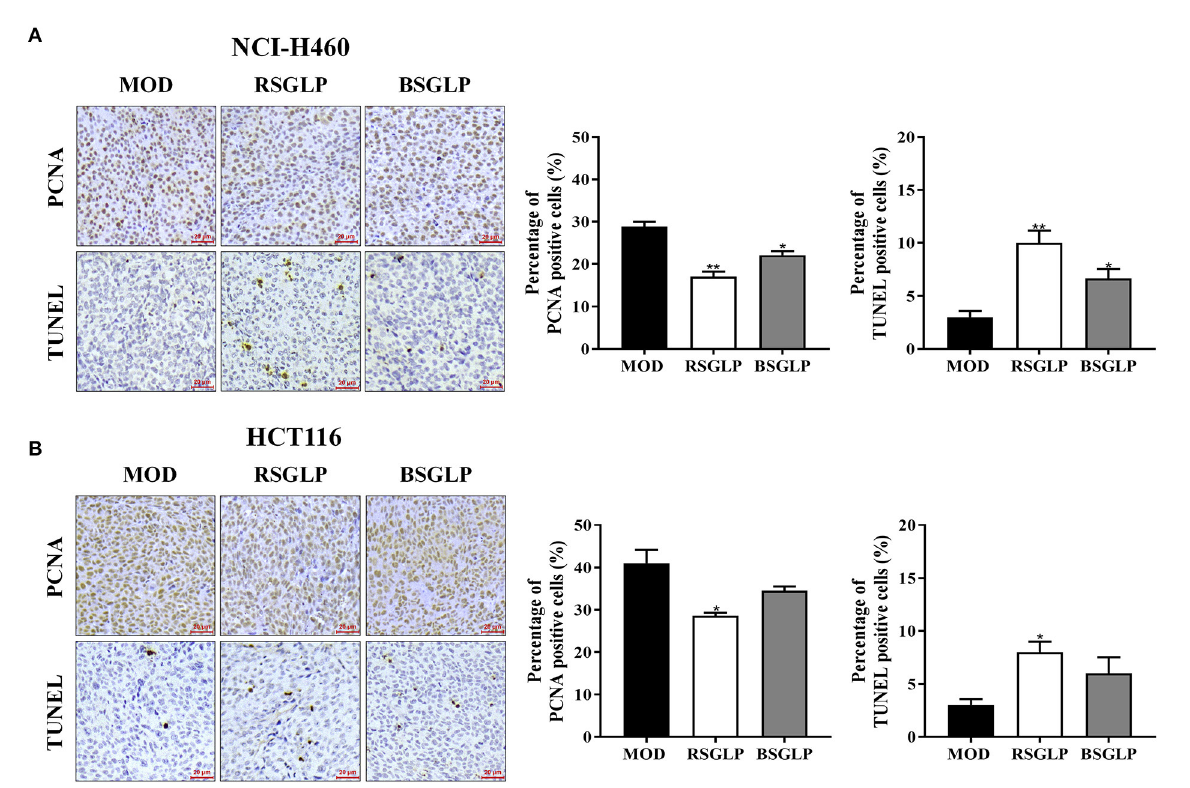
FIGURE6 Comparison of the antiproliferative and pro-apoptotic effect of RSGLP and BSGLP in xenograft tumors as determined using IHC staining. PCNA and TUNEL staining in NCI-H460 (A) and HCT116 (B) xenograft tumor sections. Images were taken under an upright Metallurgical microscope. Scale bar: 20 µ m. The percentage of positive cells was calculated by counting positive cells in tumor sections and then divided by total cells (300 cells per field, 3 fields of each section). All values are presented as the mean ± SE from 3 fields of each sample of a total of 3 samples per group. * p < 0.05, ** p < 0.01, compared with MOD